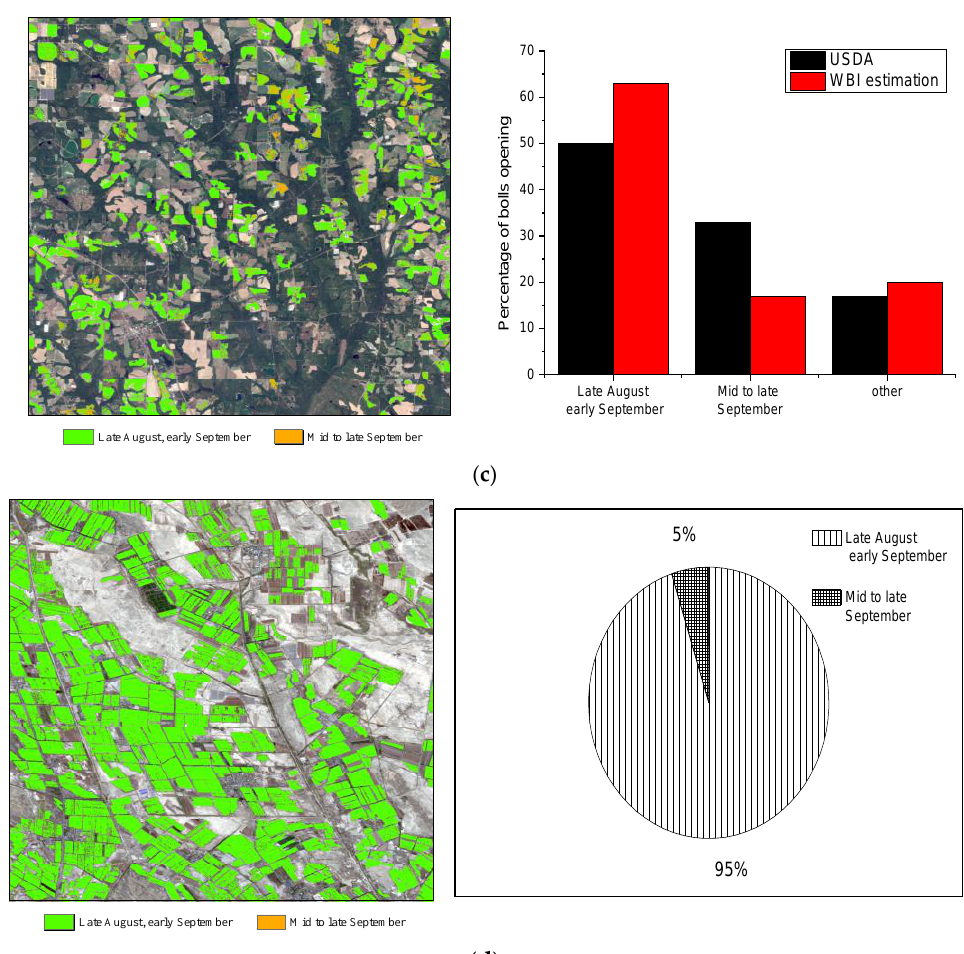
Figure 12. The bolls opening date of extraction based on WBI and compared with United States Department of Agriculture (USDA) statistic data. ( a ) MO-08, ( b ) CA-21, ( c ) GA-08, ( d ) XJ.